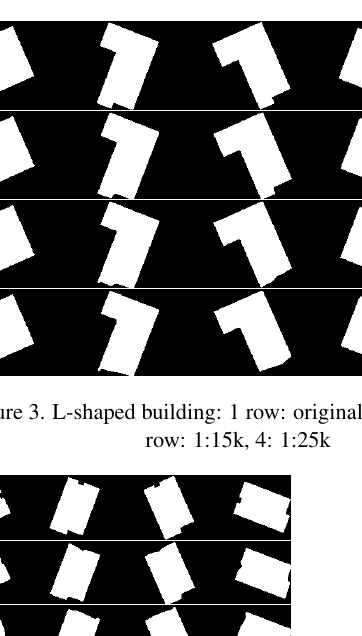
Figure 2. L-shaped building: 1 row: original, 2 row: 1:10k, 3 row: 1:15k, 4: 1:25k